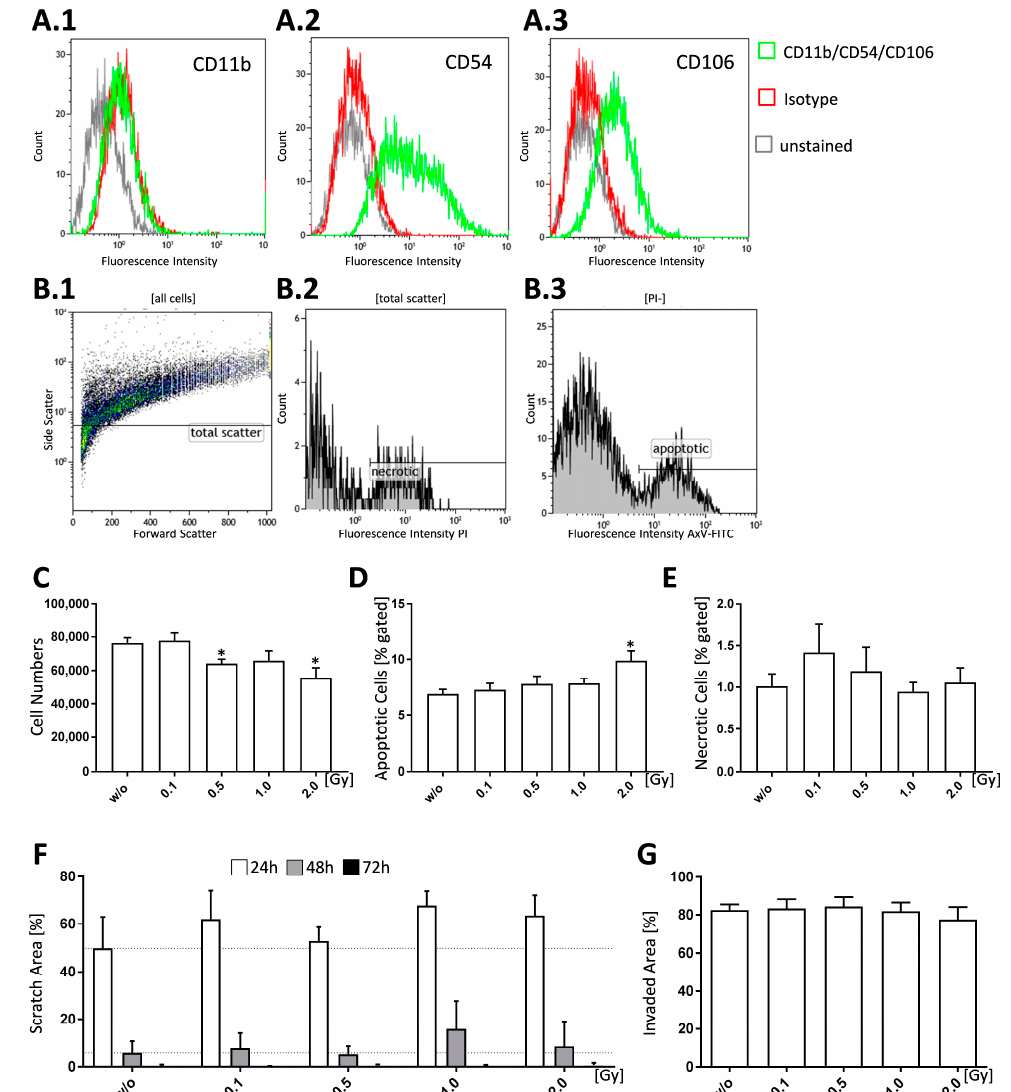
Figure 1. Low doses of ionizing radiation have no significant impact on cell death and migration properties of FLS cultures of healthy mice. Healthy FLS cultures obtained from C57Bl/6 mice were phenotyped at passage 5, seeded and analyzed 96 h after the treatment with low, intermediate, and high doses of ionizing radiation. Cell pools that were tested via flow cytometry were considered to be FLS when being CD11b − ( A.1 ), CD54 + ( A.2 ), and CD106 + ( A.3 ). B.1 to B.3 shows gating strategy for cell death analysis of FLS via flow cytometry. Cell death was determined after staining of the cells ( B.1 ., total scatter) with AxV-FITC/PI ( B.2 , B.3 ). Vital cells were defined as AxV − /PI − , necrotic ones as PI + ( B.2 , E ), and apoptotic cells as AxV + , but PI − ( B.3 , D ). Cell numbers ( C ) of living FLS were counted using a Neubauer chamber. Cell migration and invasiveness was tested via scratch assay ( F ) and matrigel invasion assay ( G ). For the scratch assay, cells were irradiated after a scratch was applied; pictures were taken every 24 h and scratch area was quantified using Tscratch (V1.0, Copyright T.Geback, M.Schulz, Zurich, Switzerland). The initial scratch area was set to 100% and scratch area of the consecutive days was calculated accordingly. For assessment of invasiveness cells were seeded in a matrigel coated transwell, irradiated and incubated for 3 days. Cells were then stained with crystal violet and invaded area was assessed using ImageJ. Depicted is data from one exemplary phenotyping experiment ( A.1 – 3 ). Data for cell growth ( C ), cell death ( D , E ), scratch assay ( F ), and invasion assay ( G ) was examined in three independently performed experiments, each being performed in triplicates, whereas, in the case of scratch assay the three same fields of view were captured every time. Data is presented as mean ± SEM and analysed by two-tailed Mann-Whitney-U test in comparison to untreated controls. (* p <